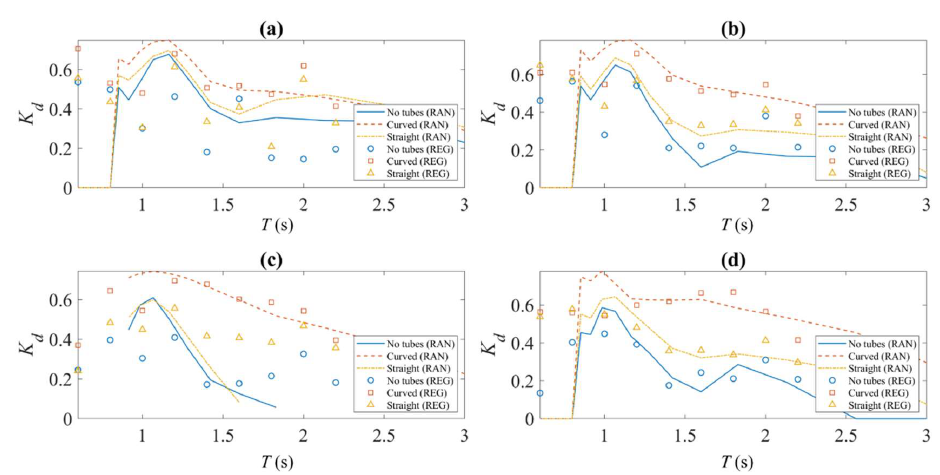
Figure 8. Dissipation coefficients for various drafts ( a ) d = 0.42 m; ( b ) d = 0.37 m; ( c ) d = 0.32 m; ( d ) d = 0.27 m for a given wave height H = 0.06 m.